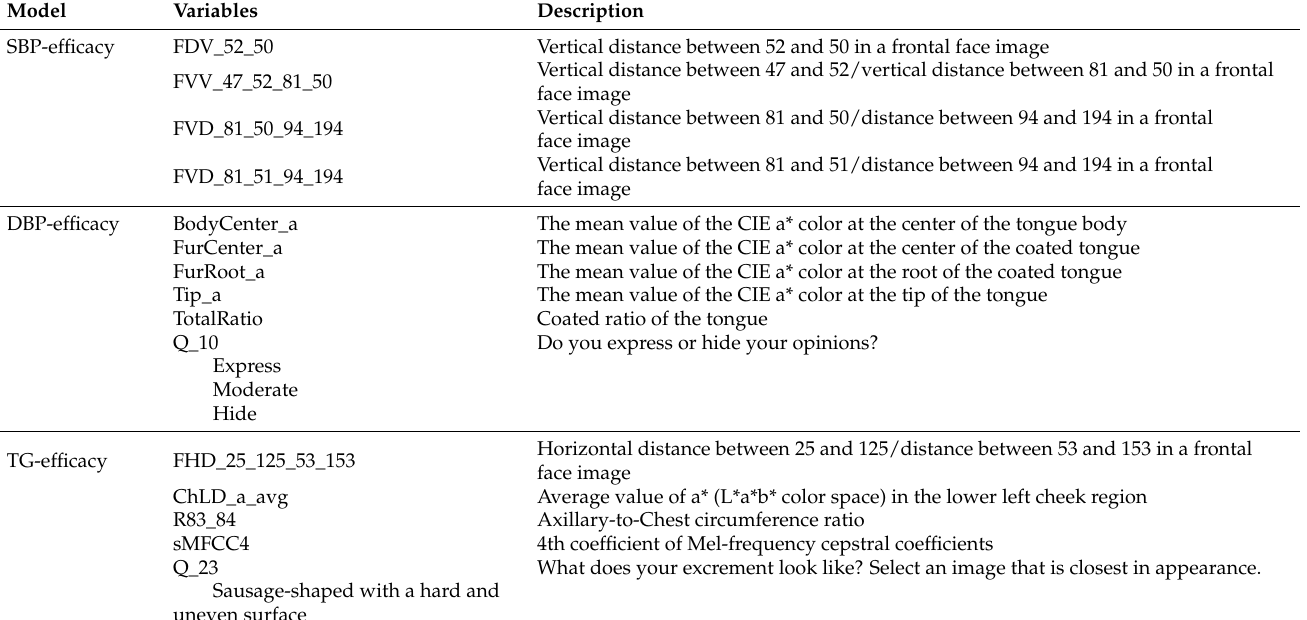
Table 2. Description of variable selection by the least absolute shrinkage and selection operator (LASSO) in each model. Model